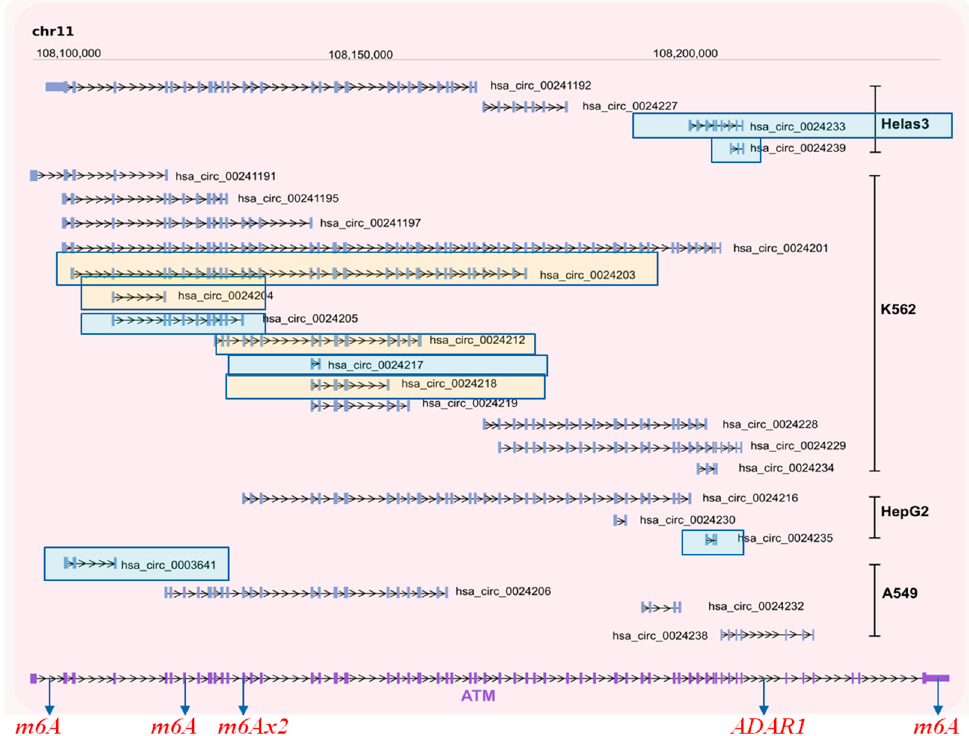
Figure 4. Potential circRNAs derived from the ATM gene locus. Predicted circRNAs at the ATM gene locus, based on NGS data, as deposited at circBase and CIRCpedia are shown over the corresponding loci, based on human genome GRCh37/hg19. Cell lines in which NGS was performed to obtain the depicted circRNAs are also shown and were retrieved from circBase. For more details, see Supplementary Figures. Furthermore, we indicate from miCLiP experiments [91] a consensus of m6A sites and editing sites as derived from RNA editing events using the Jacussa pipeline [92] as well as from ADAR1 CliP binding sites.